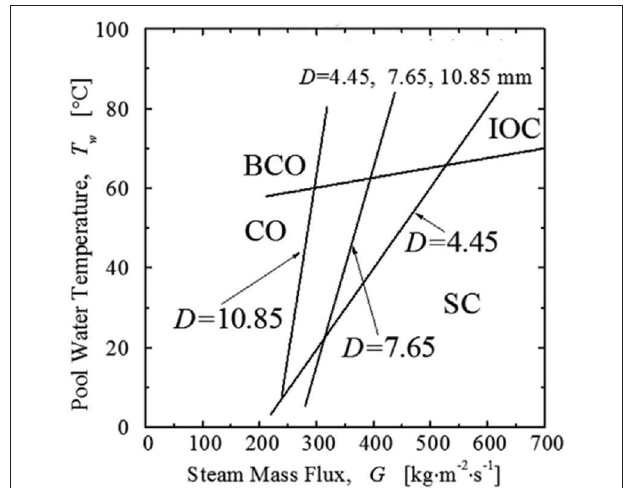
FIGURE 4 | The regime map developed by Chun et al. (1996). Chun et al. (1996) conducted experiments and developed the regime map, as shown in Figure 4 . The steam flux in the experiment varied from 200 to 700 kg/m 2 s, while the water temperature varied from 12 to 83 ◦ C. The diameters of the pipe varied from 4.45 to 10.85 mm. Chun classified the regimes in which the steam–water interface is almost stable into three categories: conical, ellipsoidal, and divergent